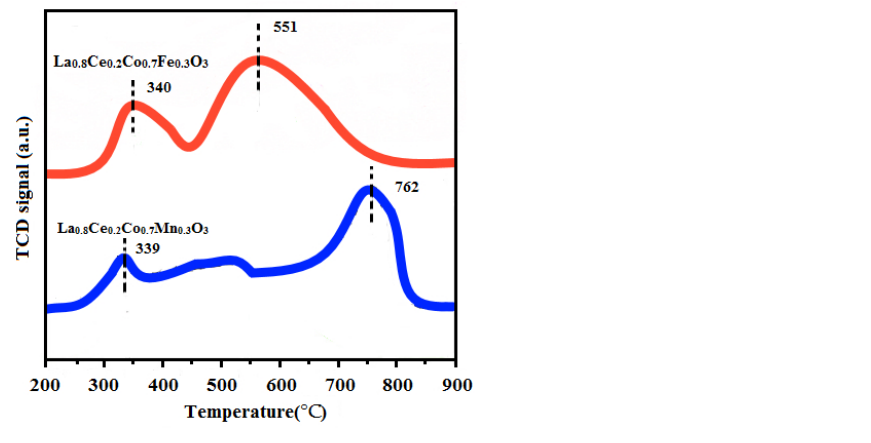
Figure 15. H 2 -TPR profiles of La 0.8 Ce 0.2 Co 0.7 Fe 0.3 O 3 and La 0.8 Ce 0.2 Co 0.7 Mn 0.3 O 3.